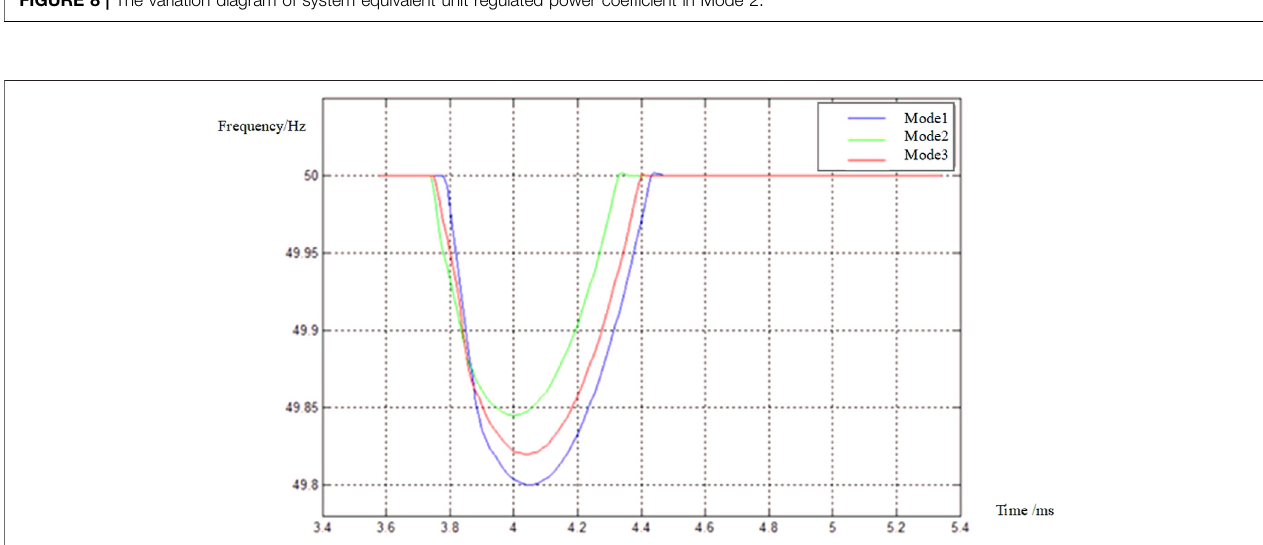
FIGURE 8 | The variation diagram of system equivalent unit regulated power coef fi cient in Mode 2.